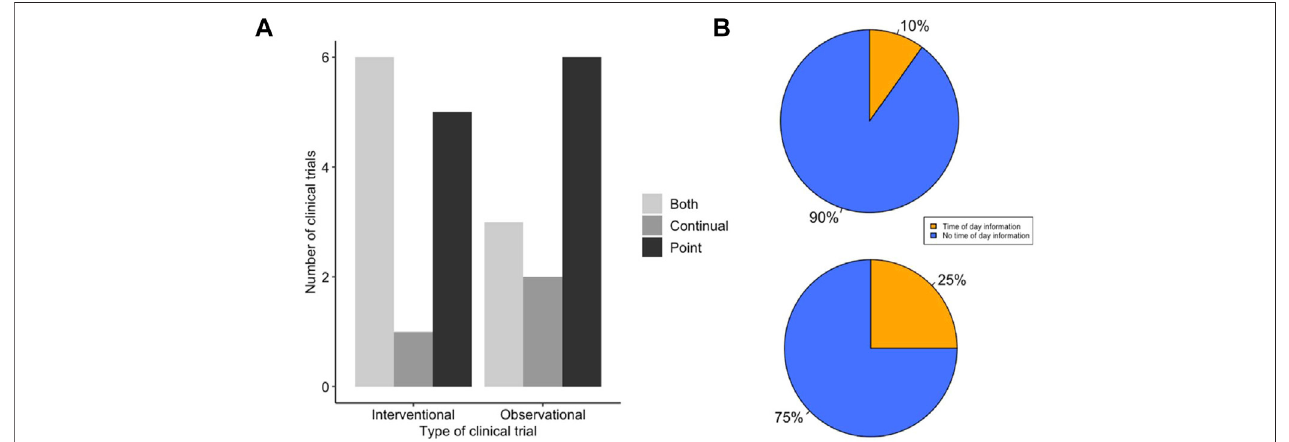
FIGURE 3 | LQTS trials make low use of time of day information for ECG measurement. (A) Method of ECG recording used for LQTS clinical trial outcomes. Trials are grouped together aseither interventional or observational studies. Trialswere scored for whether outcomes reported ECG measurements determined by point ECG measurement (black), continual using Holter monitor (dark grey) or outcomes that used both point and continuous measurements (light grey). (B) Distribution of LQTS trials that accounted (orange) or did not account (blue) for time of day information when (top) recording or analysing point ECGs and (bottom) analysing continual